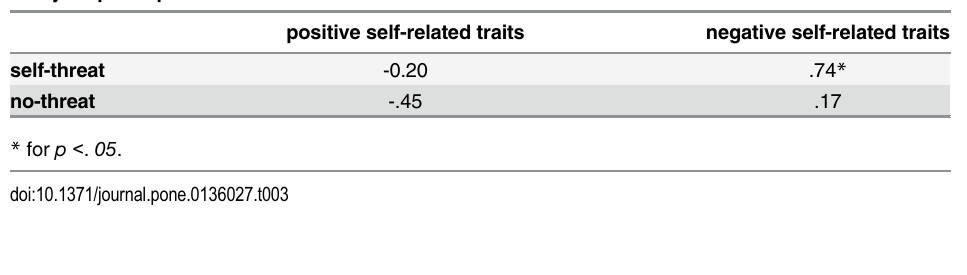
Table 3. Correlations between trait self-esteem and the self-related traits response latencies sepa- rately for participants with and without